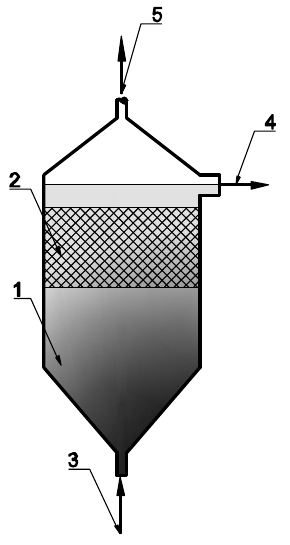
Figure 8. Diagram of a hybrid reactor: 1—suspended sludge zone, 2—bed, 3—raw wastewater, 4—treated effluent.